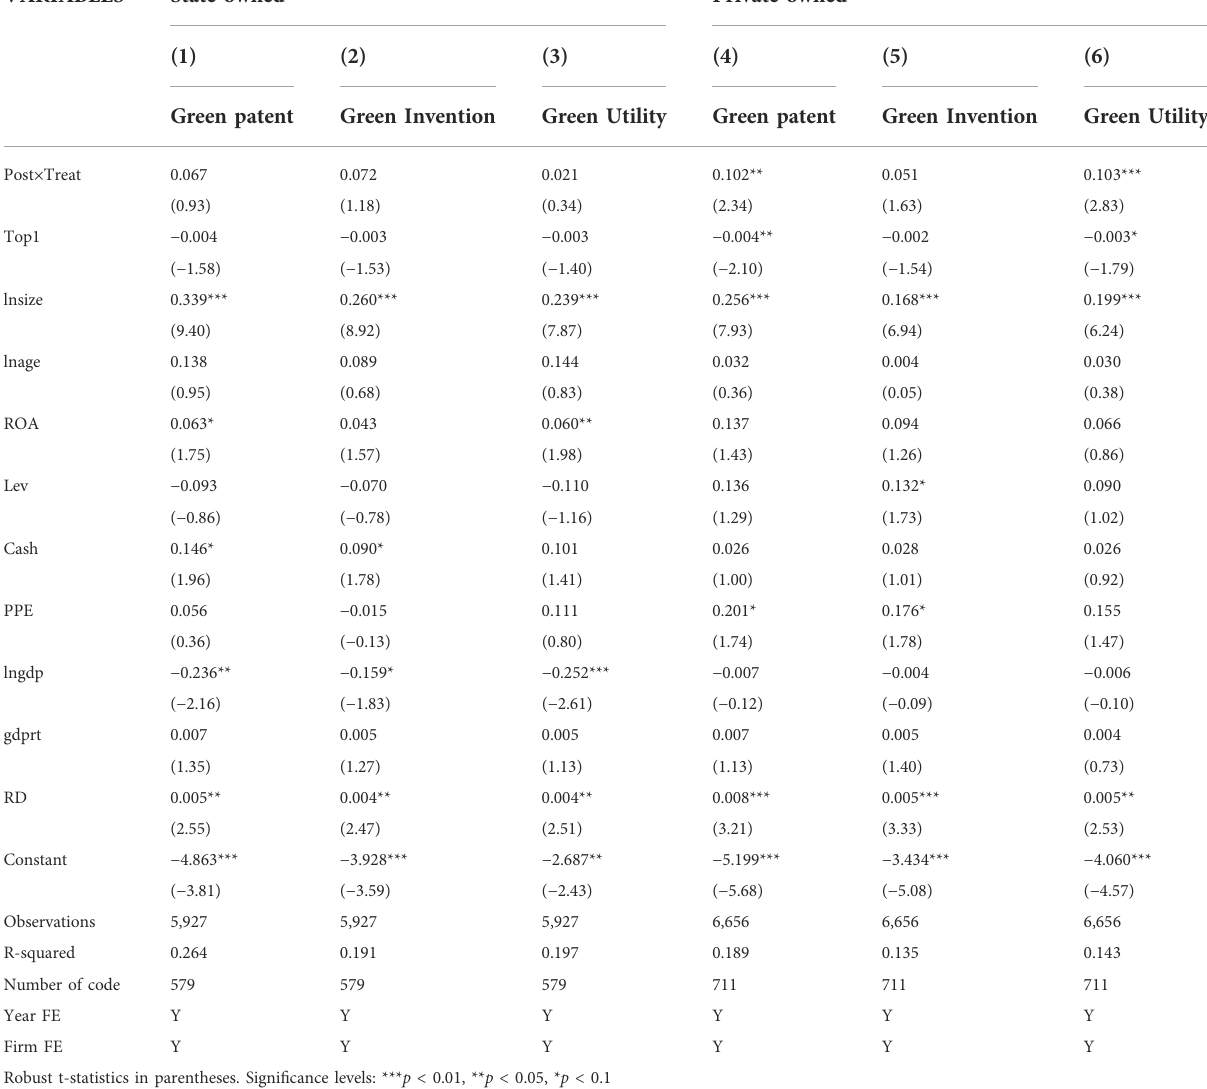
TABLE 4 Impact of low-carbon city pilot policy and ownership on green innovation.